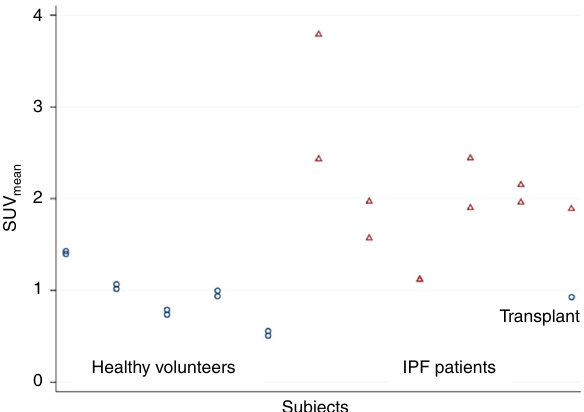
Fig. 7 Mean SUVs of healthy volunteers and IPF patients. Mean SUVs from healthy volunteers and IPF patients are shown as circles and triangles, respectively. The single transplanted lung in patient IPF-4 is shown as a circle (far right). The right/left mean SUVs for patient IPF-3 were identical and appear as a single triangle (Supplemental Table 13). The right/left correlation is 0.90 and 0.70 for HVs and IPF patients, respectively. The average SUV mean s ± S.D.s for the right lungs of HVs ( n = 5) and the IPF group ( n = 6) is 0.92 ± 0.33 and 2.04± 0.91, respectively ( p =